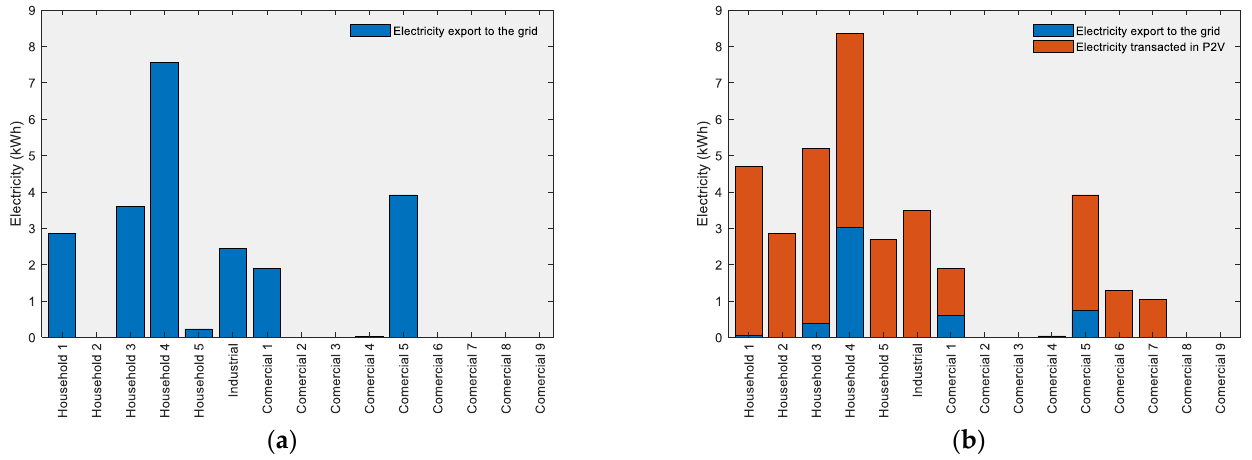
Figure 5. Electricity exported (grid and P2V transactions): ( a ) Scenario 1 and ( b ) Scenario 2.